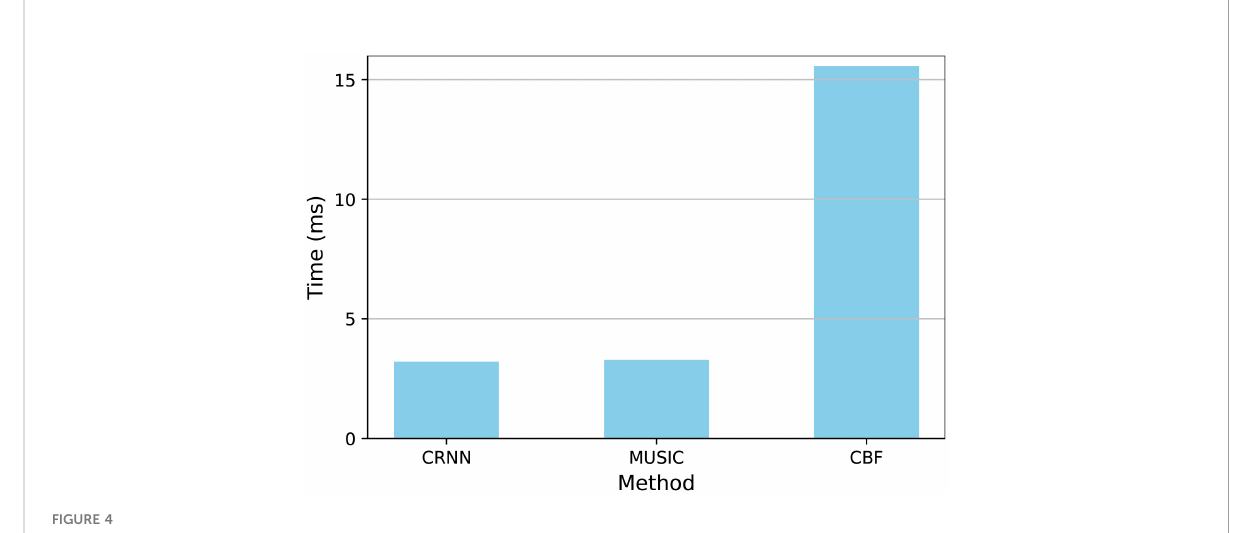
FIGURE 4 Estimation times of different methods.